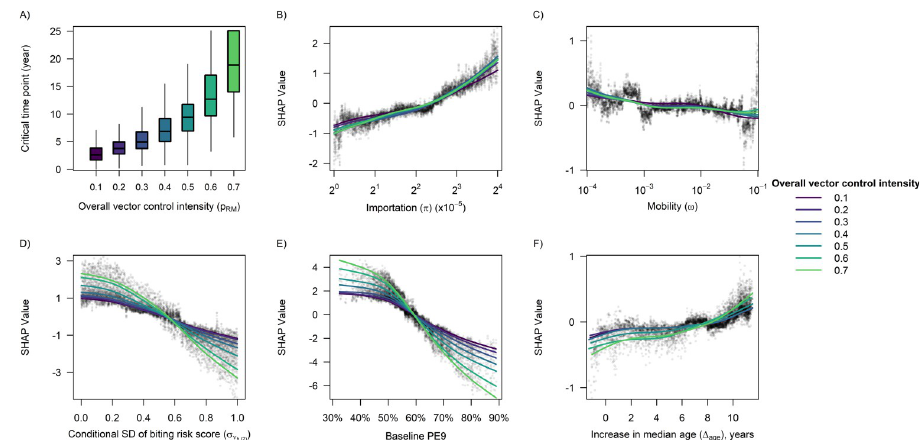
Fig 4. Impact of different predictor variables on the critical time point. For (A), the original values of the critical time point obtained from the simulations were summarized. Each box was drawn from the first quartile (Q1) to the third quartile (Q3) of the data, with the horizontal line in the middle showing the median. The upper whisker boundary was the largest observation that was within Q3 + 1.5 � (Q3—Q1), and the lower whisker boundary was the smallest observation above Q1–1.5 � (Q3—Q1). Data points beyond the whisker boundaries were omitted from the graph for clarity. For (B)—(F), we used SHAP values to quantify the change in the predicted critical time point due to the value of each predictor variable, where each point represents a single simulation run and each curve was obtained by fitting a smoothing spline to the set of data points corresponding to a given overall level of vector control intensity. We excluded simulations where the overall level of vector control intensity was 0.8 or higher, due to the high probability that vector control remained effective throughout the 30-year intervention period.